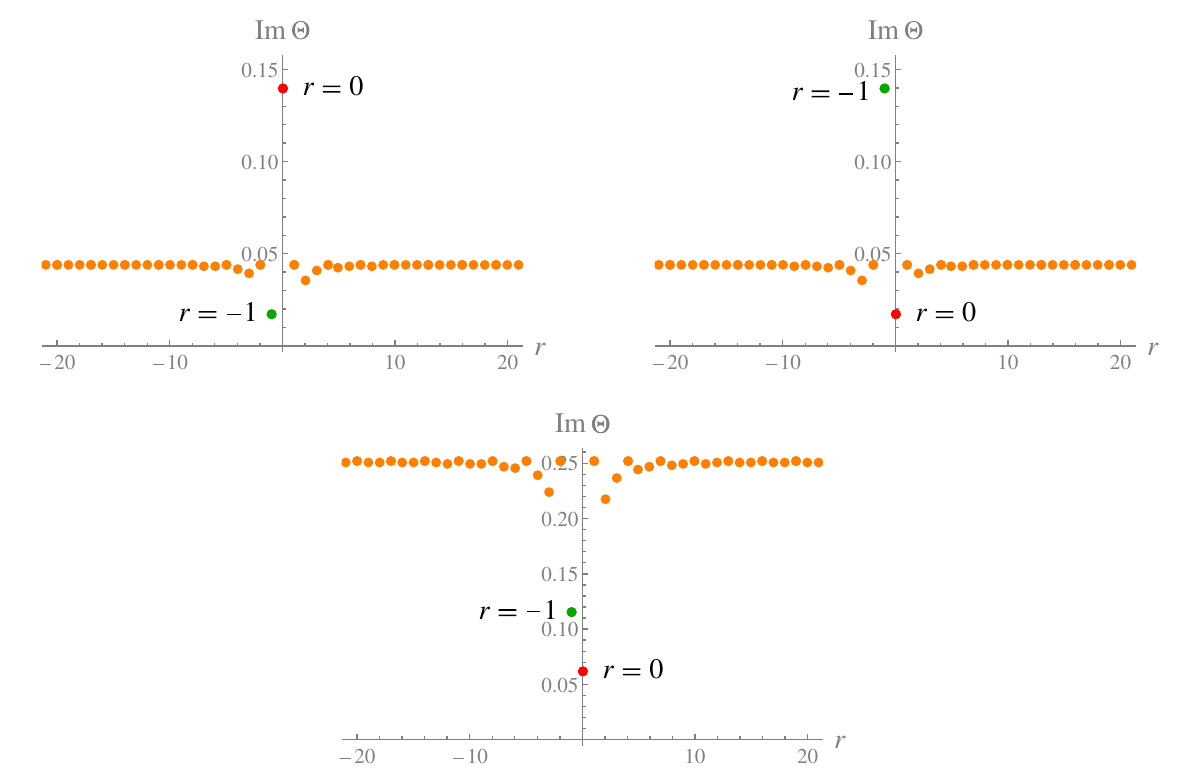
FIG. 2. The upper-left plot shows the values of Im Θ ð Δ ; τ þ r Þ as a function of r , for a sample value of τ inside the semicircle (130). The red dot corresponds to r ¼ 0 , which is the dominant contribution in this case. The upper-right plot shows Im Θ ð Δ ; τ þ r Þ for τ inside the semicircle (131). The green dot corresponds to r ¼ − 1 , which is the dominant contribution in this case. The lower plot shows the values of Im Θ ð Δ ; τ þ r Þ for τ outside the two semicircles, where there is no dominant